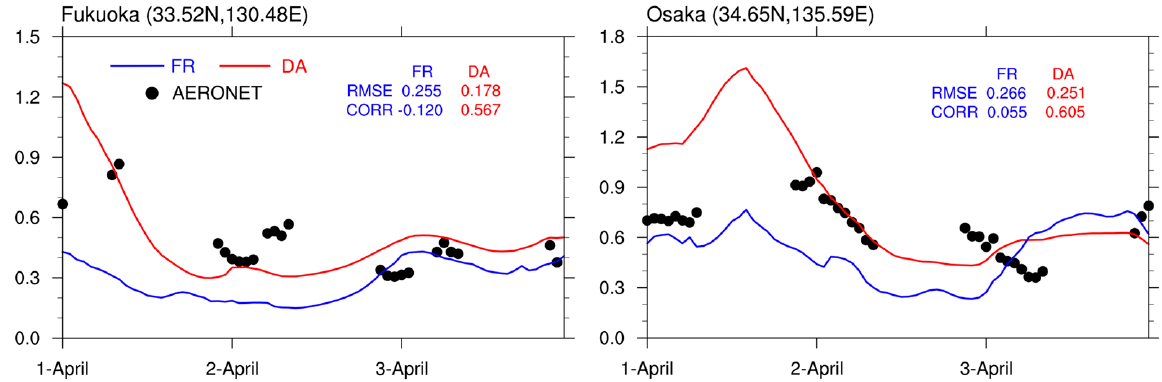
Figure 9. Time series of simulated AOTs at 440 nm for two experiments (FR in blue and DA in red) and AERONET-observed AOTs (dots in black) at 440 nm over two sites. Root mean square errors (RMSEs) and correlations (CORRs) between AOTs simulated by the two experiments and the AERONET-observed AOTs are also shown.